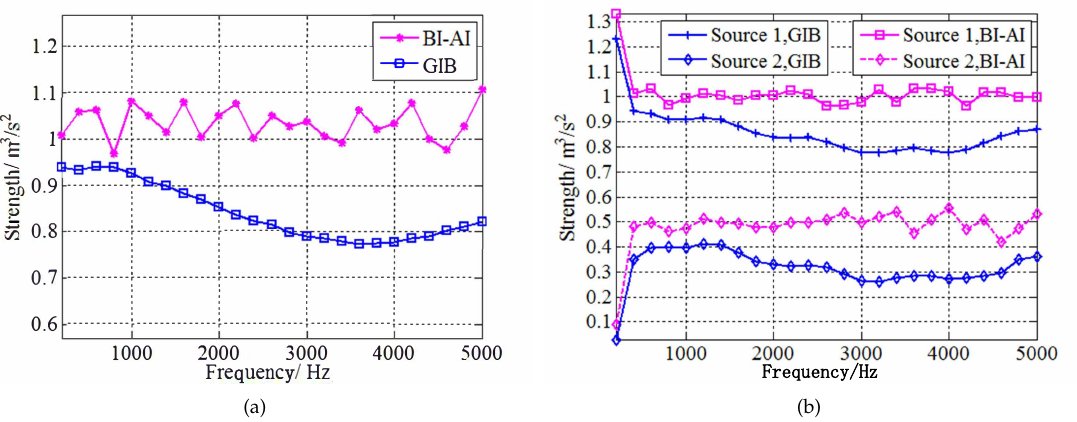
Figure 5. The strength estimation varying radiation frequency (20 inner iterations, 300 outer iteration). ( a ) one unitary monopole; ( b ) two coherent monopole sound sources, the strength of sources is 1 and 0.5, respectively.